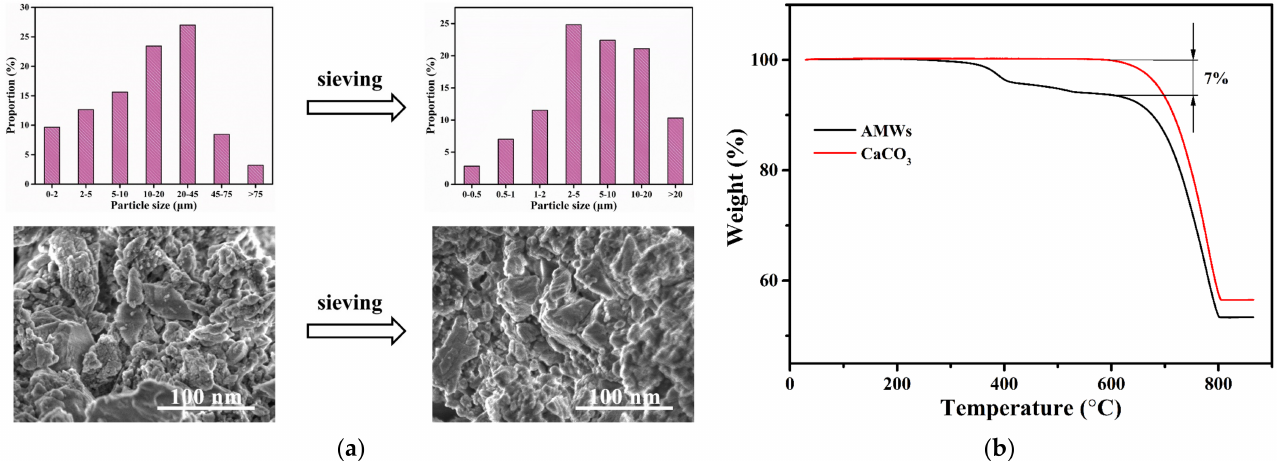
Figure 2. ( a ) Particle size distribution and SEM images before and after sieving of AMWs; ( b ) TGA curves of AMWs and CaCO 3 .